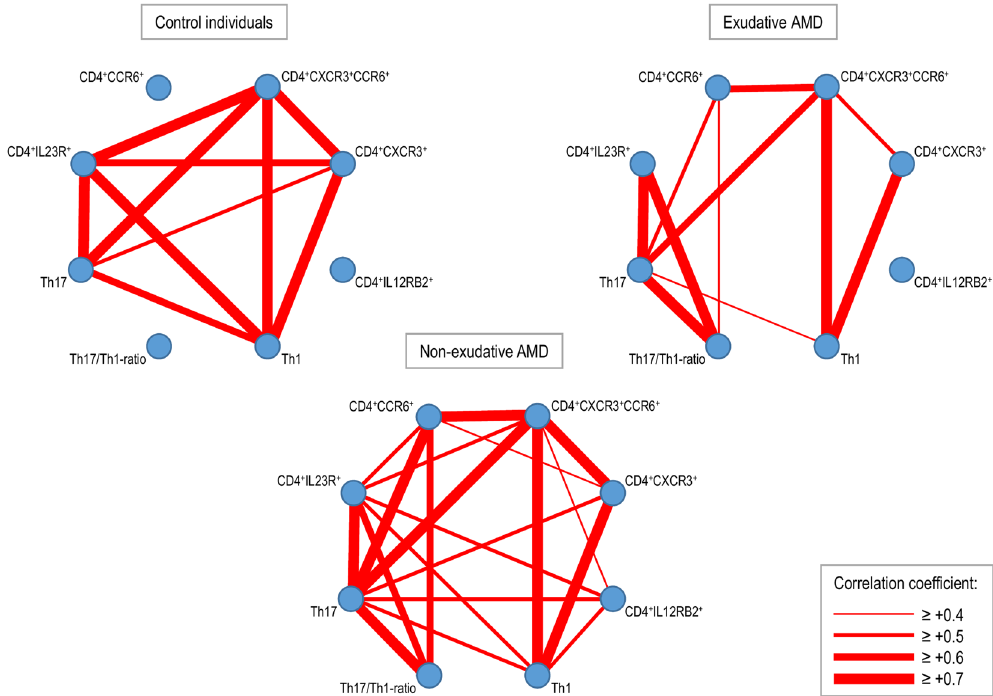
Figure 2. Correlation networks of CD4 + T-cell surface proteins in control individuals, patients with non- exudative age-related macular degeneration (AMD), and patients with exudative AMD. The relationships between surface proteins are calculated using Spearman’s correlation and the correlation coefficient is marked when ≥ 0.4 or ≤− 0.4 using green or red lines, respectively. Differences in relationship patterns reveal that a complex systemic immune dysfunction may be present in patients with